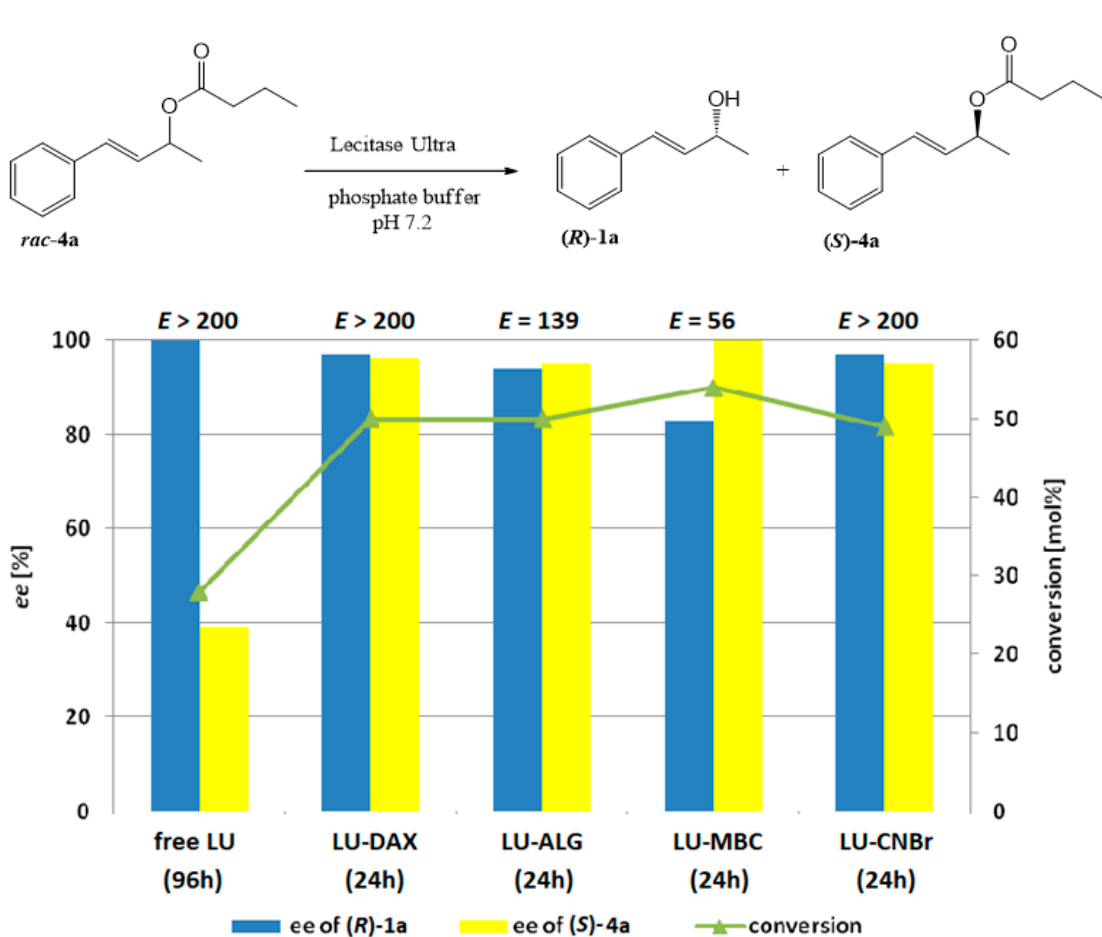
Figure 3. The effect of enzyme immobilization on the conversion, enantioselectivity, and enantiopurity of the products of Lecitase ™ Ultra-catalyzed hydrolysis of racemic butyrate 4a ( reaction scheme presented above)